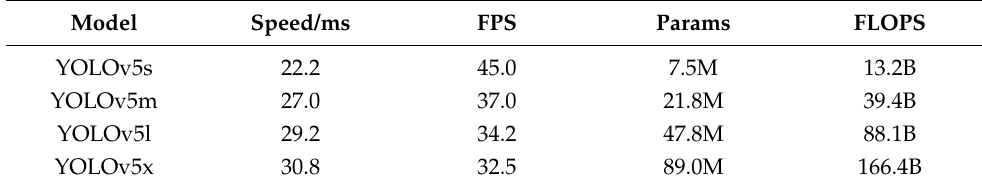
Table 2. A comparison of yolov5 detection model results.